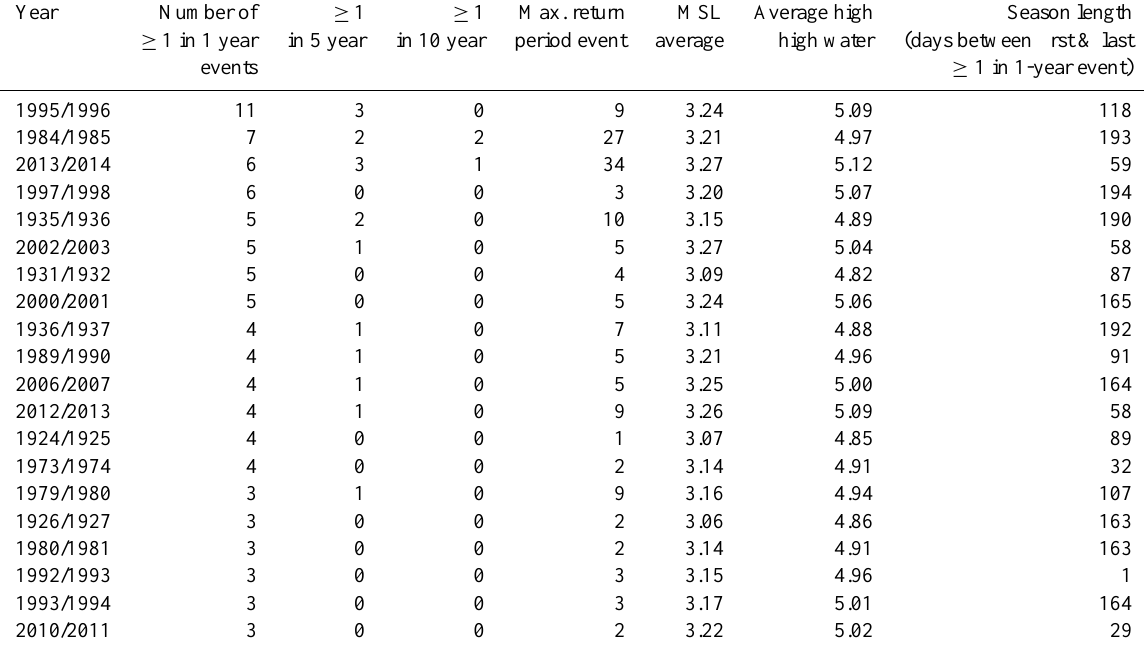
Table 4. Newlyn’s storm seasons which have registered ≥ 3 occurrences of sea level events exceeding the (offset) 1 in 1-year return period (ordered by this and then the exceedance of the 1 in 5-year return period). Also shown are the largest return periods and length of each “season” (as defined by events occurring of ≥ 1 in 1-year return